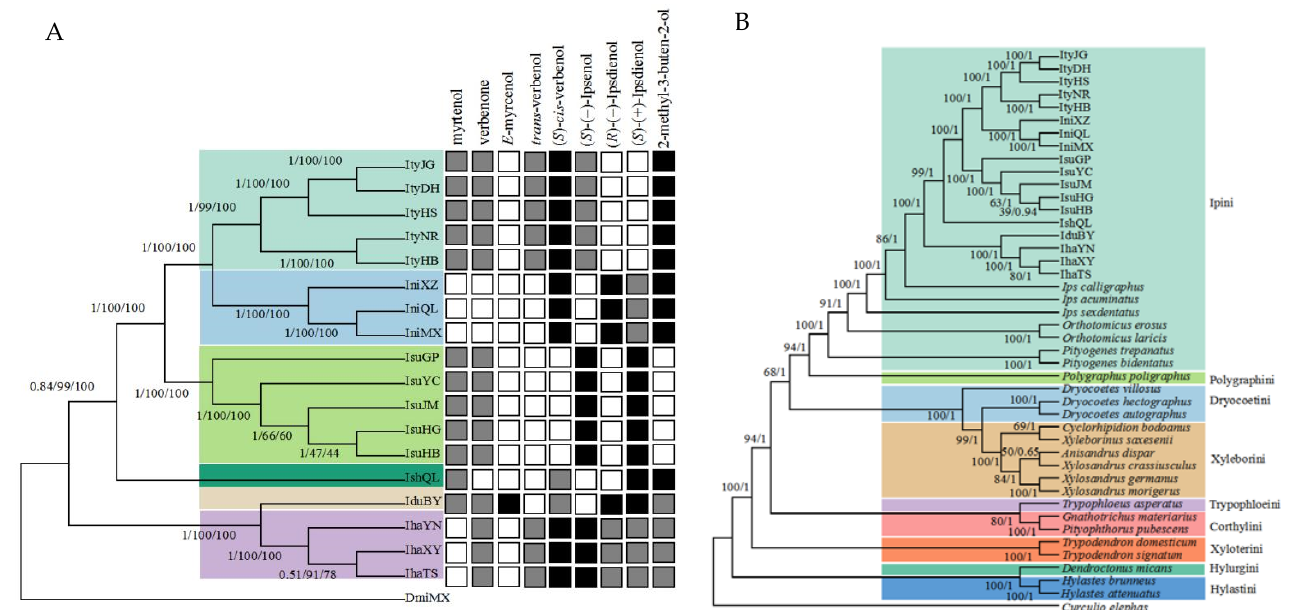
Figure 1. ( A ) Phylogenetic trees (Bayesian tree [BI], maximum parsimony [MP], and maximum likelihood [ML]) of Ips bark beetles based on PCGs, with pheromone components superimposed. Numbers above or below branches indicate bootstrap values for BI, ML, and MP, respectively. Different colored clades indicate different species branches. The black squares on the right represent major components of beetle pheromones, the gray squares represent minor components, and the white squares represent beetles that do not use this component as a pheromone. ( B ) Phylogenetic tree (Bayesian tree [BI] and maximum likelihood [ML]) of bark beetles under higher order element based on mtDNA. Numbers above and below branches indicate bootstrap values for BI and ML, respectively.